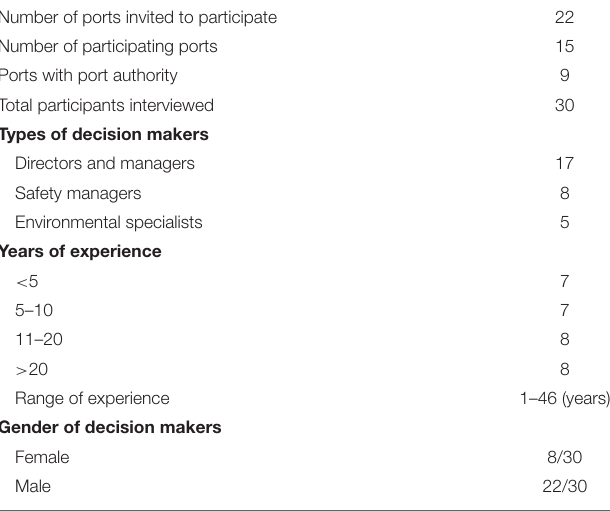
TABLE 2 | Demographics representing the study’s participating decision